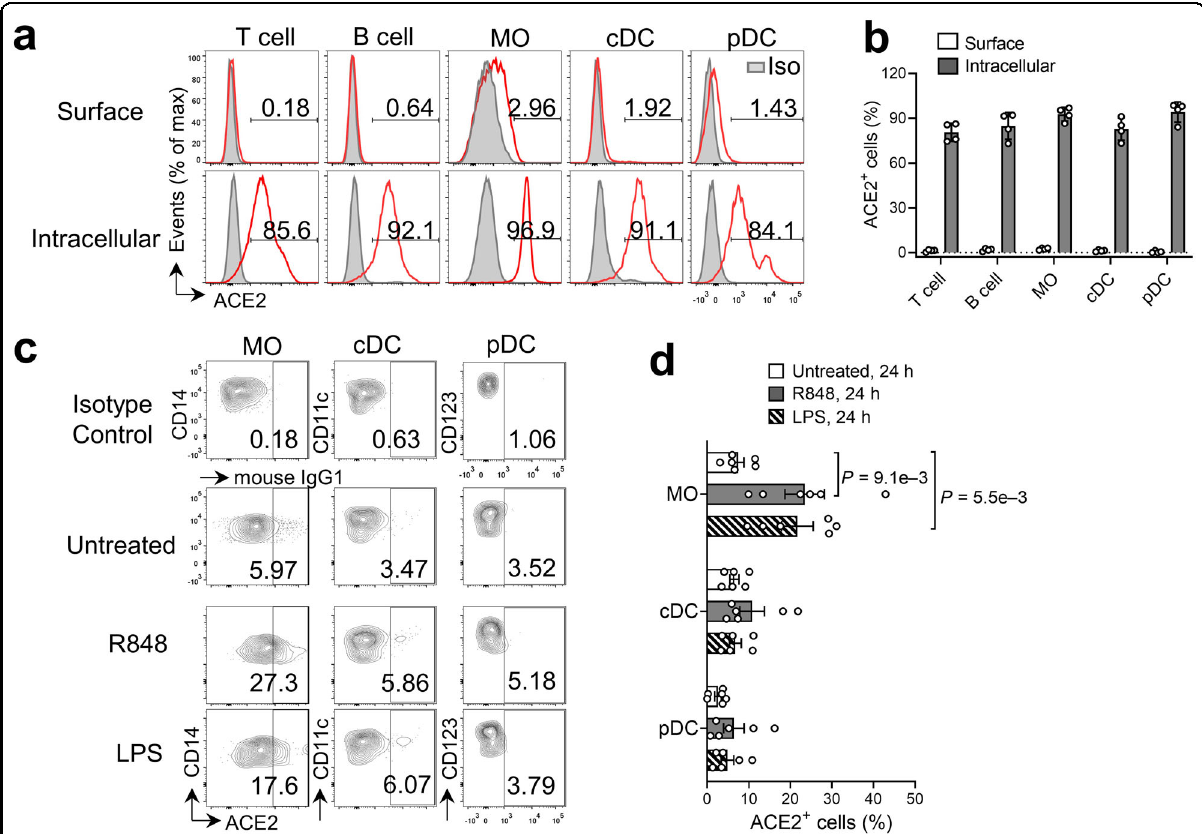
Fig. 1 Upregulation of ACE2 expression on the cell surface of peripheral blood myeloid populations upon ex vivo TLR stimulation. a Representative fl ow cytometry analysis of ACE2 protein expression (red line) in T cells, B cells, CD14 + MO, cDCs, and pDCs from fresh PBMCs isolated from healthy donors. Mouse IgG1 antibody (gray tinted) was used as isotype control. b Frequency of cells expressing cell surface and cytoplasmic ACE2 as in ( a ) ( n = 4 biologically independent samples/group). c PBMCs were cultured ex vivo with or without R484 or LPS for 24 h, followed by fl ow cytometry analysis of surface ACE2 in CD14 + MO, cDCs, and pDCs. Mouse IgG1 antibody was used as the isotype control. d Frequencies of indicated cell types expressing surface ACE2 as in c ( n = 6 biologically independent samples/group). cDC classical dendritic cells, pDC plasmacytoid DCs, MO monocytes, LPS